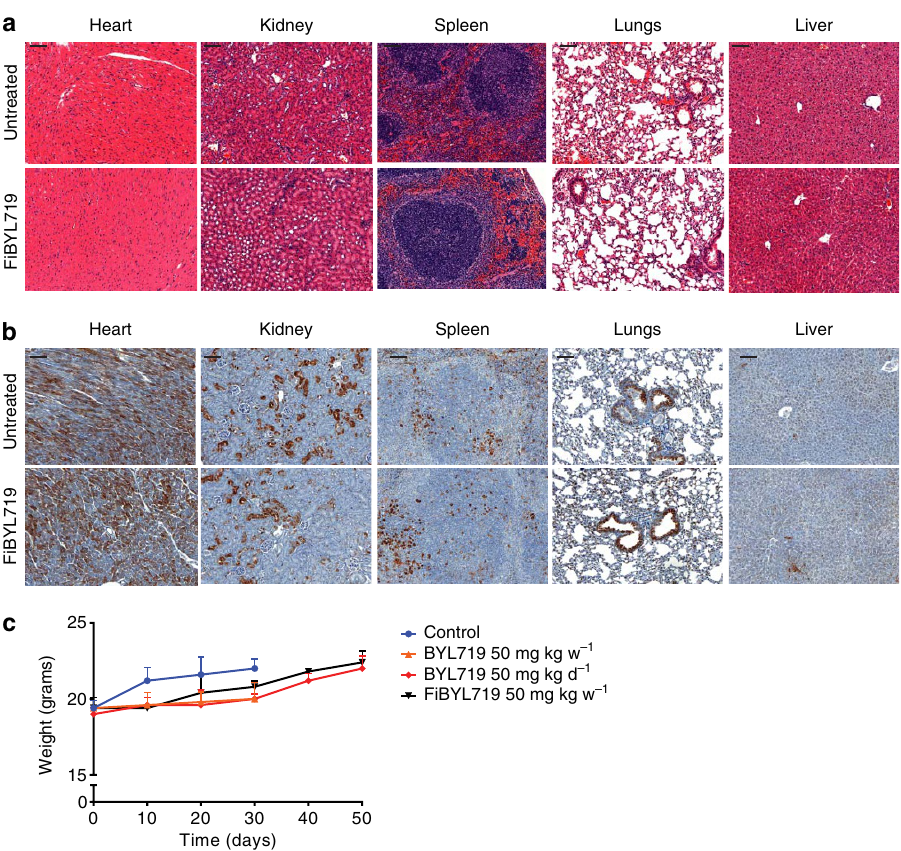
Figure 5 | Systemic toxicity profiles of FiBYL719 nanoparticles. ( a ) Representative images of H&E staining in different organs of mice treated with bi-weekly i.v. injections of 25mgkg (cid:2) 1 FiBYL719 for 14 days ( n ¼ 2), scale bar, 100 m m. ( b ) Representative images of immunohistochemical stains of pS6 in organs of mice treated bi-weekly with i.v. injections of 25mgkg (cid:2) 1 FiBYL719 for 14 days ( n ¼ 2), scale bar, 100 m m. ( c ) Body weight of tumour-bearing mice treated with oral administration of either 50 or 7mgkg (cid:2) 1 BYL719 daily, or i.v. injections of 25mgkg (cid:2) 1 FiBYL719 bi-weekly ( n ¼ 10). Error bars indicate mean ±